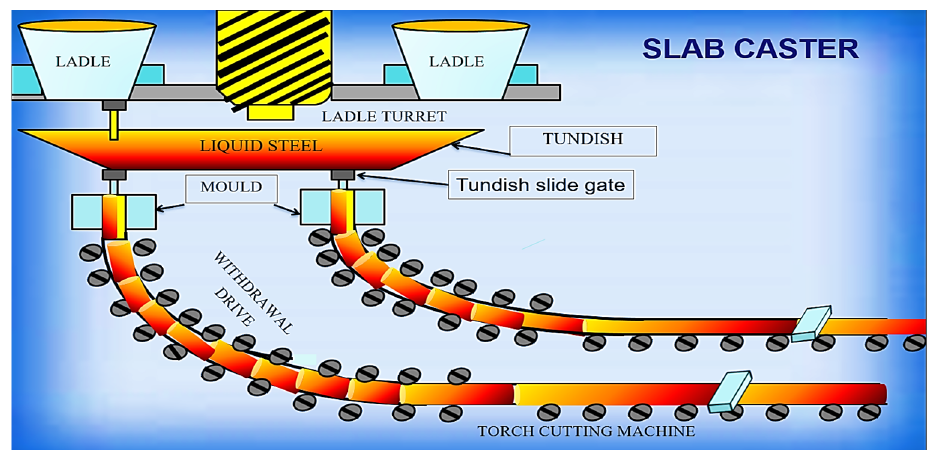
Figure 5. Schematic diagram continuous casting process.